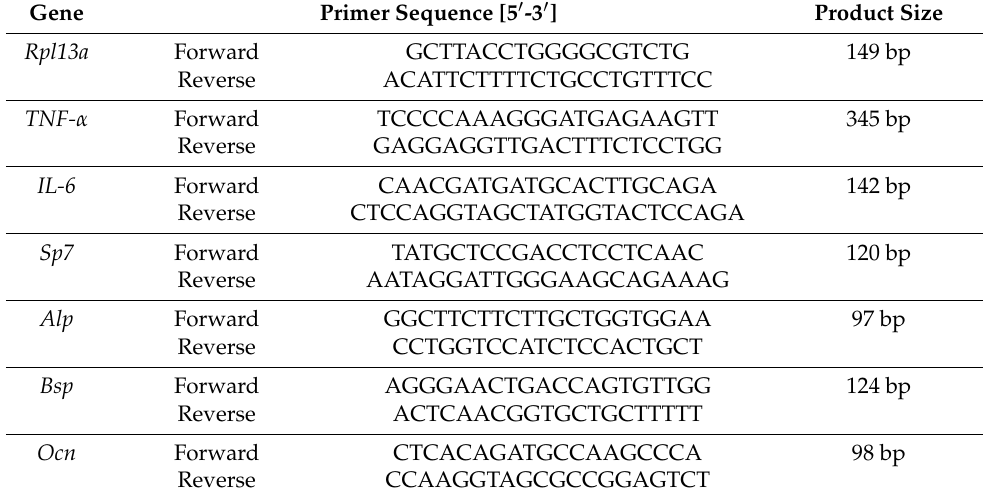
Table 1. Primer sequences used in this